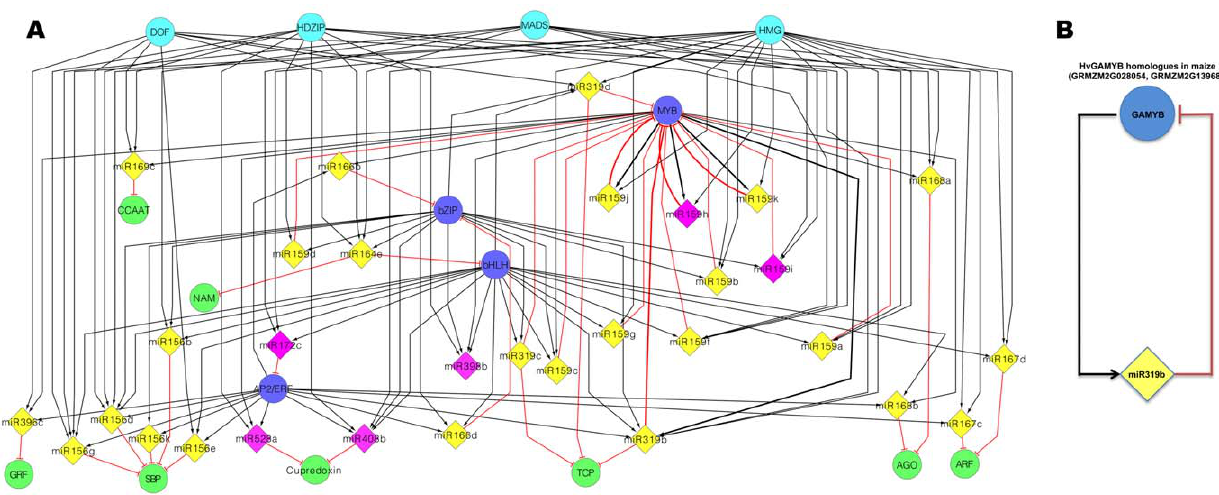
Figure 9. miRNA-mediated gene regulatory sub-network of short-term waterlogging stress in B73. A. TF-miRNA and miRNA-target interactions are shown. B. Probable negative feedback loop between GAMYB and miR319b is shown. Upstream motifs and downstream targets are indicated as circular nodes whereas miRNA are denoted as diamond nodes. Teal color TF nodes represent the upstream motifs, light green nodes represent miRNA targets, whereas royal blue color nodes denote TFs which are involved in both upstream and downstream interactions. Yellow color miRNA shows down regulated miRNAs whereas violet color shows up regulated miRNAs. TF-miRNA interactions are shown as black arrows whereas downstream miRNA-target interactions are shown as red color lines.